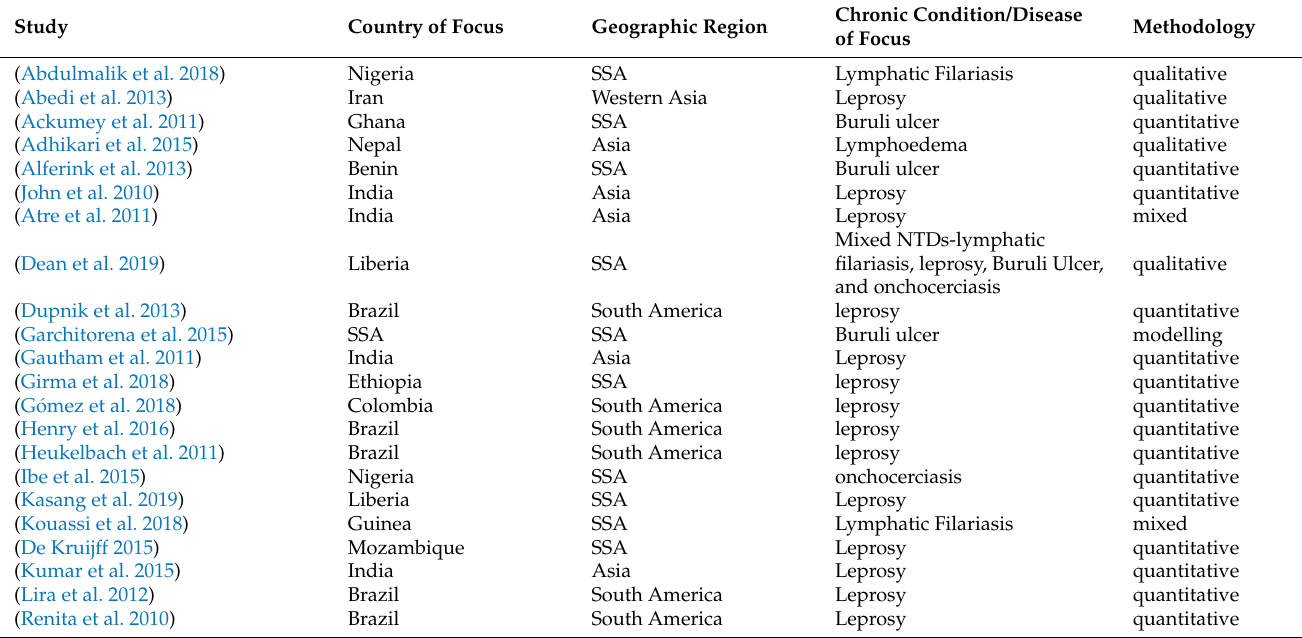
Table 2. Overview of included